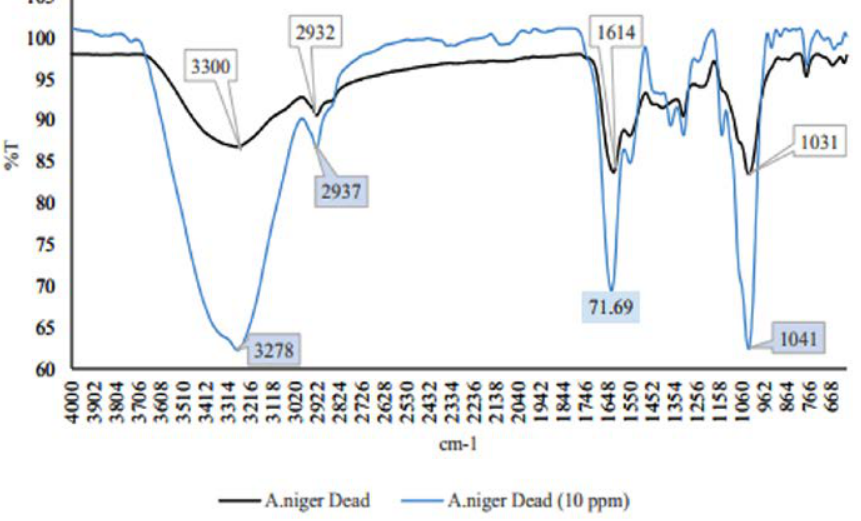
Fig. 2 . FTIR data of dead cells of A. niger before and after the absorption in 10 ppm Hg